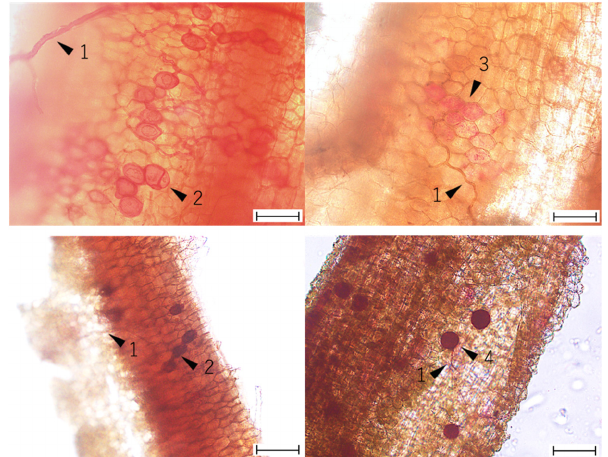
Figure 1. Photomicrograph of root samples stained with acid fuchsin. The top pictures and the bottom pictures were roots in MS and SPS, respectively. Bar = 100 µm; arrow 1: hypha; arrow 2: vesicle; arrow 3: arbuscule; arrow 4: spore.